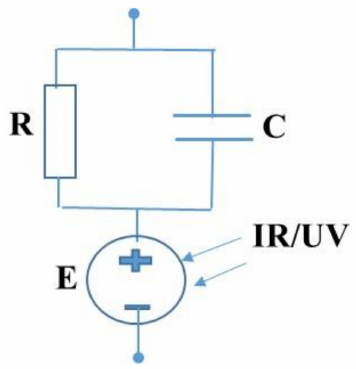
Figure 6. Simplified equivalent circuit of the Al/OD-Gel/Cu electrochemical cell which contains parallel connection of the resistance (R) and capacitance (C) with voltage source connected in series.